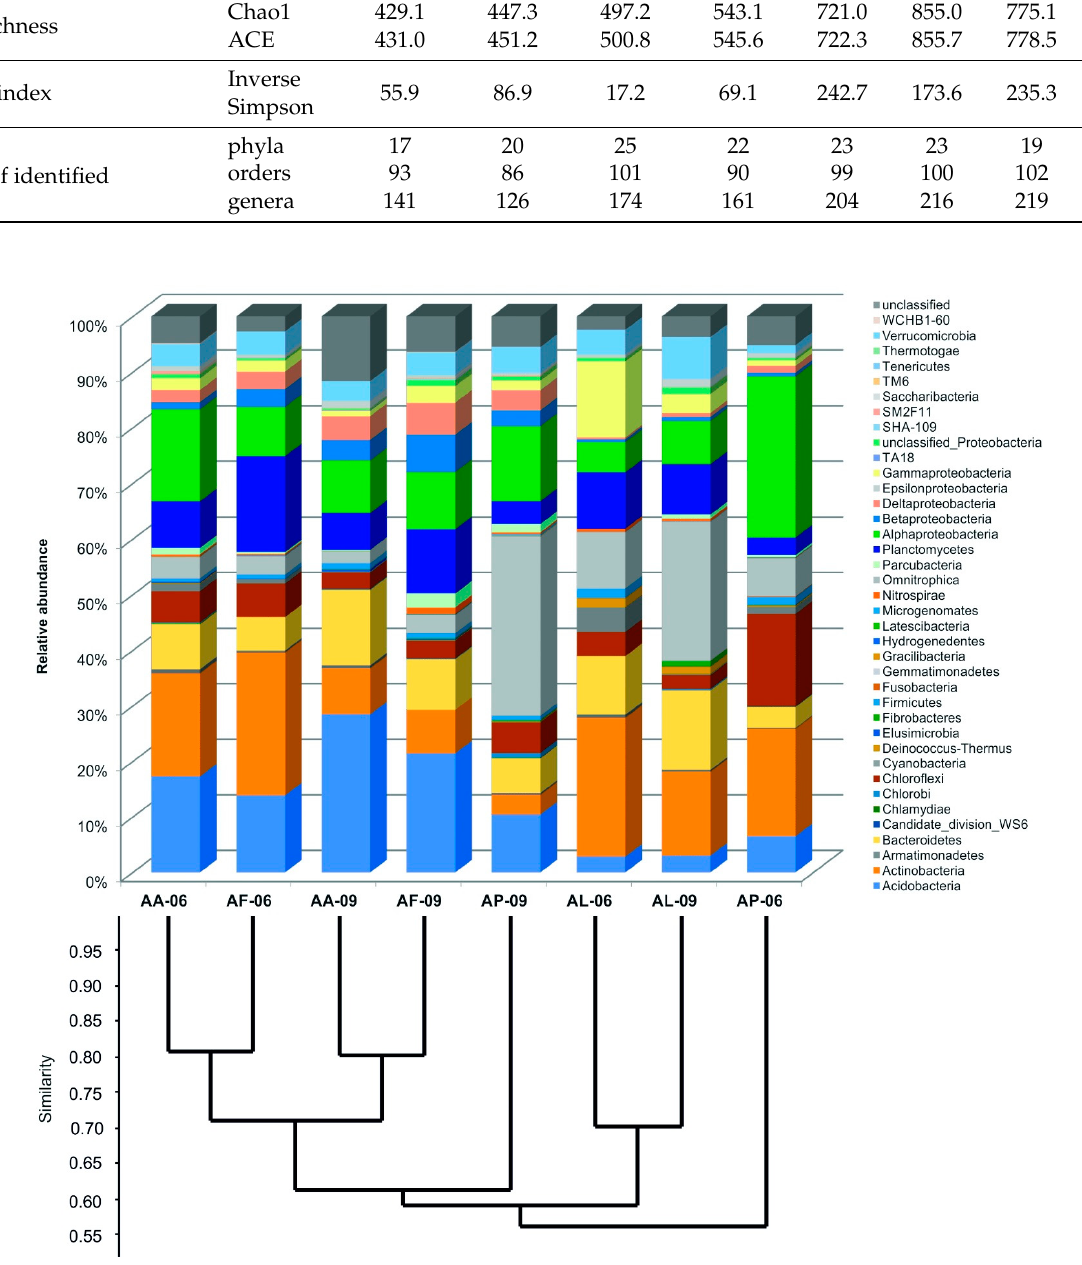
Figure 4. Percentage distribution of 16S rRNA gene amplicon sequences among recognized phyla and candidate divisions together with the results of Bray–Curtis similarity index-based cluster analysis created according to the distribution of OTUs in the sodic soil samples originated from different alkali vegetation. Sample identifiers are presented in Table